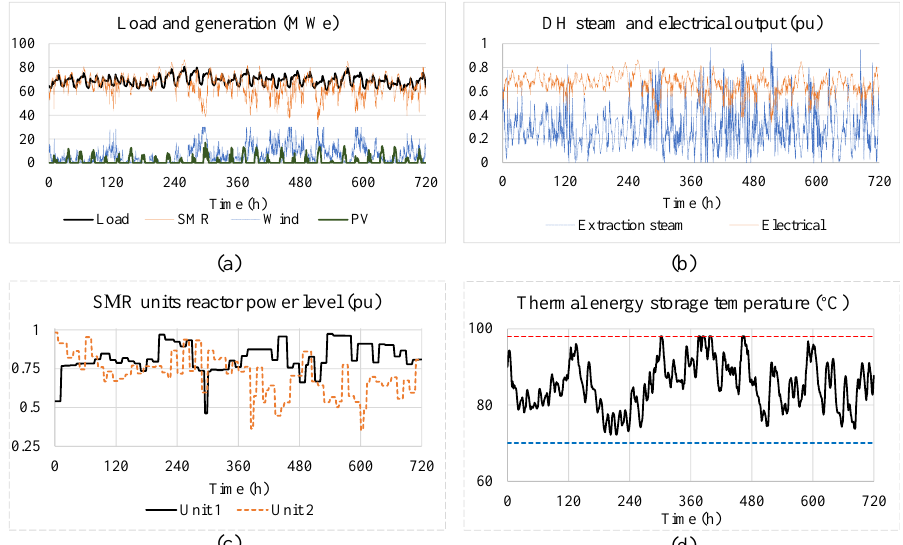
Figure 9. Quasi-static simulation results for 720 h with 15 min resolution: ( a ) load and generation; ( b ) DH steam and electrical output; ( c ) SMR units reactor power level; ( d ) thermal energy storage